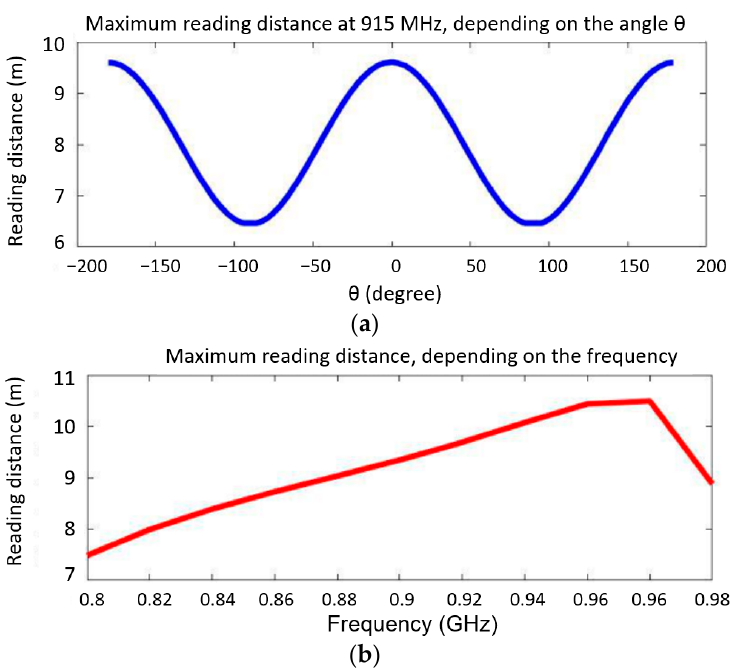
Figure 7. The maximum reading distance ( a ) at 915 MHz depending on the angle θ and ( b ) depending on the frequency.